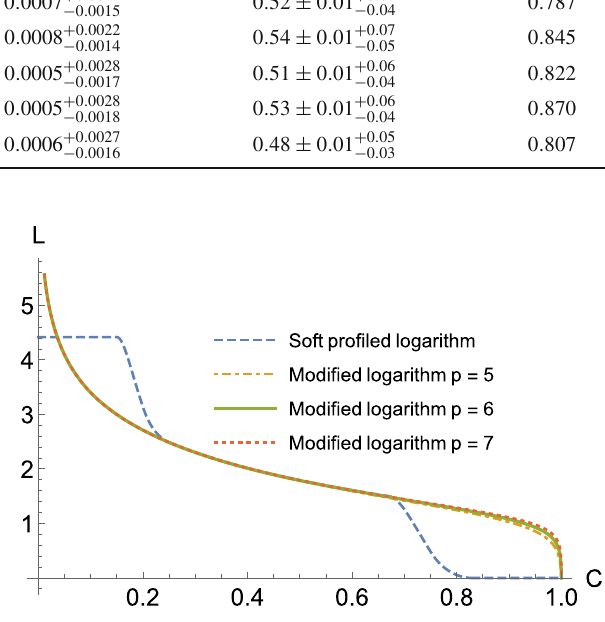
Table 3 Results of fits for α s and α 0 using the different functional forms for ζ( C ) , as in Table 2, but with an assumption of uncorrelated experimental uncertainties instead of the minimum overlap